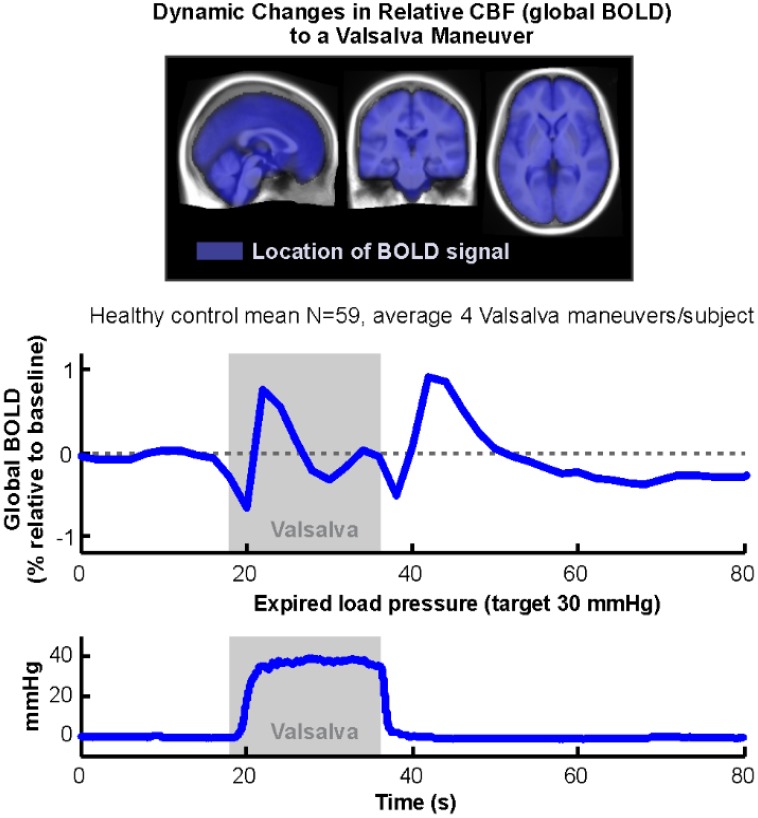
Global BOLD signal during an average of four Valsalva challenges averaged over 59 healthy subjects (18 s duration, target pressure 30 mmHg, starting at time 18 s). Mean of expiratory pressures in bottom graph. All subjects achieved target pressure for all four challenges. Blue overlays on average anatomical background indicate locations from which global BOLD signal was calculated (Data from Macey et al., 2014).